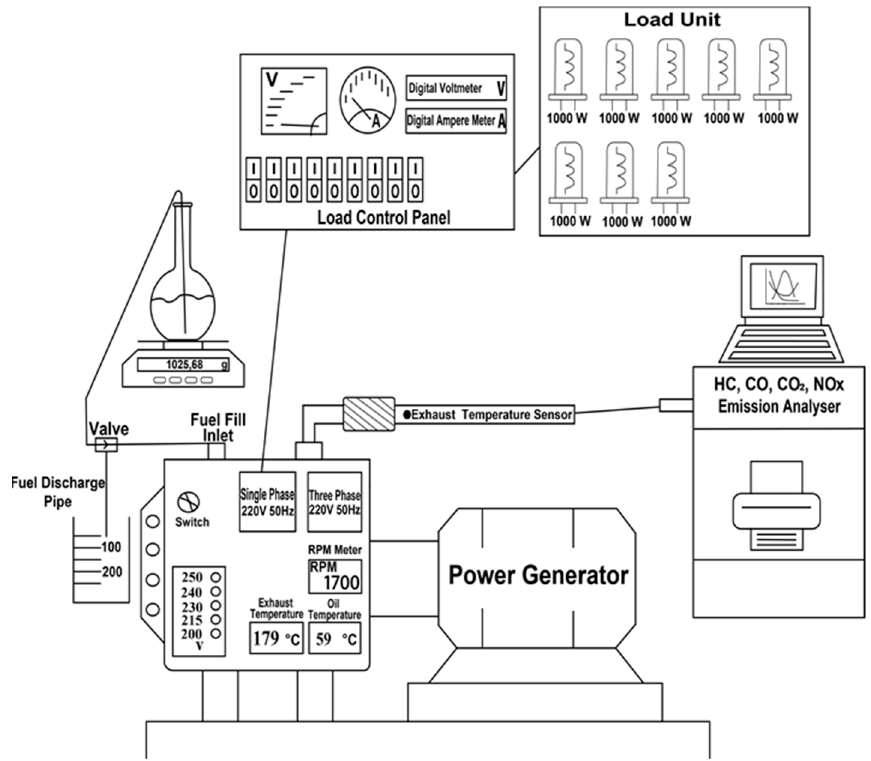
Figure 3. Overview of experimental setup.